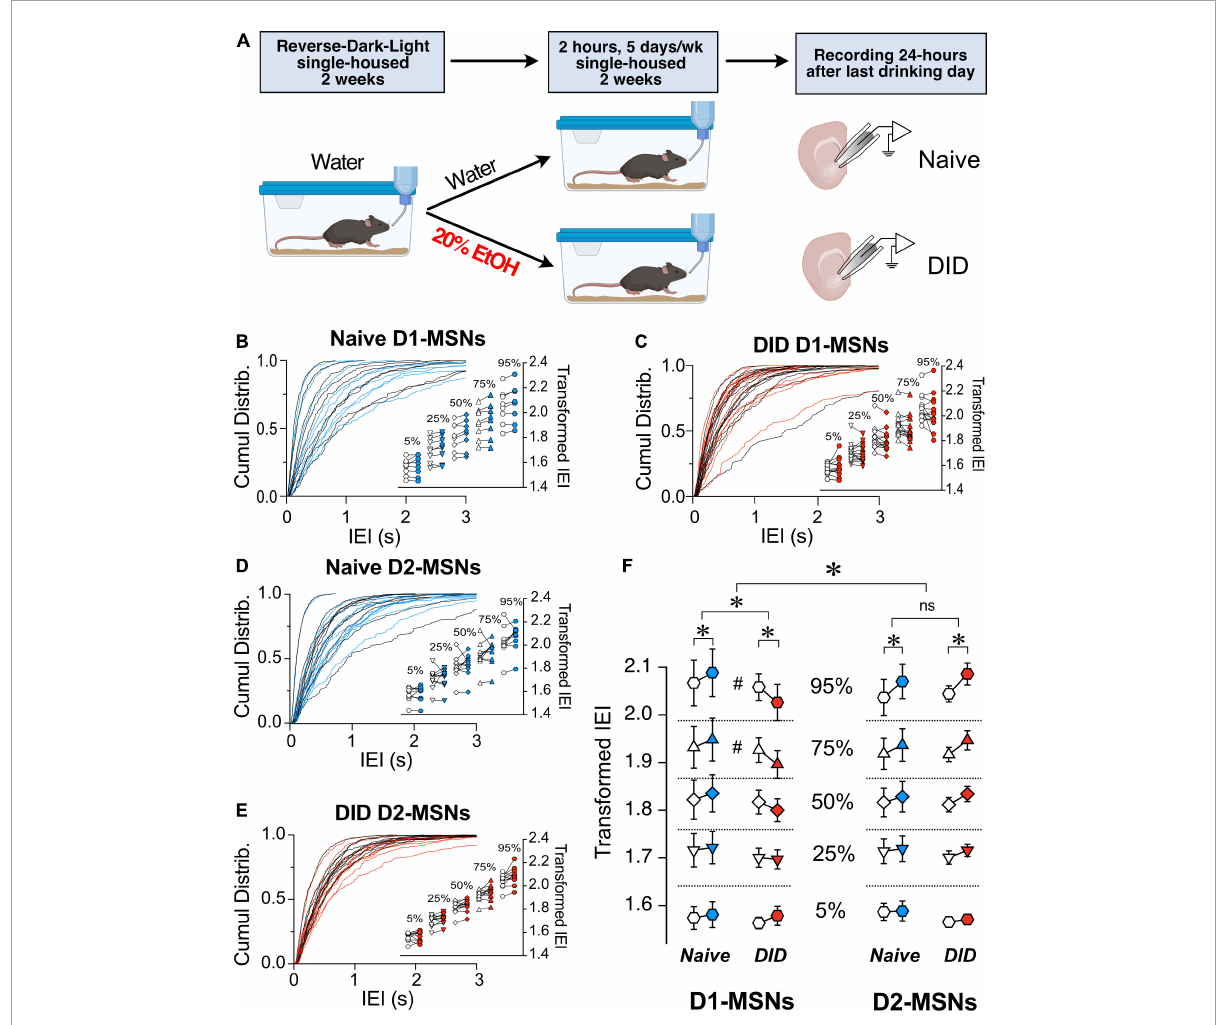
FIGURE5 Binge alcohol drinking differentially affects the control by ChI on glutamate release in D1 and D2R MSNs. (A) Schematic of drinking in the dark (DID) treatment. Mice were single-housed at 4–5 weeks of age and placed into reversed dark-light schedule to habituate for 2 weeks and then given either water (Naïve group) or 20% EtOH (DID group) every day for 2 h, 5 days a week for 2 weeks. Brain slices were then isolated, and MSNs’ sEPSCs recorded. (B) Cumulative frequency distribution of D1-MSN IEI of sEPSCs in ChAT-ChR2 mice group before (Pre, black traces) and after (Post, blue traces) ChI optogenetic stimulation. Each solid line represents a neuron. Average traces for Pre and Post conditions are shown in dotted black and blues lines, respectively. Inset. Cumulative distributions of D1-MSNs EPSCs IEIs in ChAT-ChR2 mice broken into percentiles of distribution to quantify median (50%), shoulders (25 and 75%), and extreme values (5 and 94%) of distribution, that are 1ˆ10 transformed to normalize the distribution. (C) Same as panel (B) in DID mice. Black and red traces indicate IEI before and after ChI, respectively ( n = 14). (D) Cumulative frequency distribution of D2-MSN IEI of sEPSCs in ChAT-ChR2 mice before (Pre, black traces) and after (Post, blue traces) ChI optogenetic stimulation. Each solid line represents a neuron. Average traces are shown in dotted black and blues lines for Pre and Post conditions, respectively. Inset. Cumulative distributions of ChAT-ChR2 D2-MSNs EPSCs IEIs broken into percentiles of distribution to quantify median (50%), shoulders (25 and 75%), and extreme values (5 and 94%) of distribution, that are 1ˆ10 transformed to normalize the distribution ( n = 10). (E) Same as panel (B) in DID mice. Black and red traces indicate IEI before and after ChI, respectively ( n = 11). (F) Percentiles of cumulative distribution of transformed IEIs of EPSCs in Naïve ChAT-ChR2 (Pre, white circles, Post, blue circles) and DID ChAT-ChR2 (Pre, white circles, Post, red circles) in D1- and D2-MSNs. * p < 0.05, # p < 0.05, ns, no significant difference.